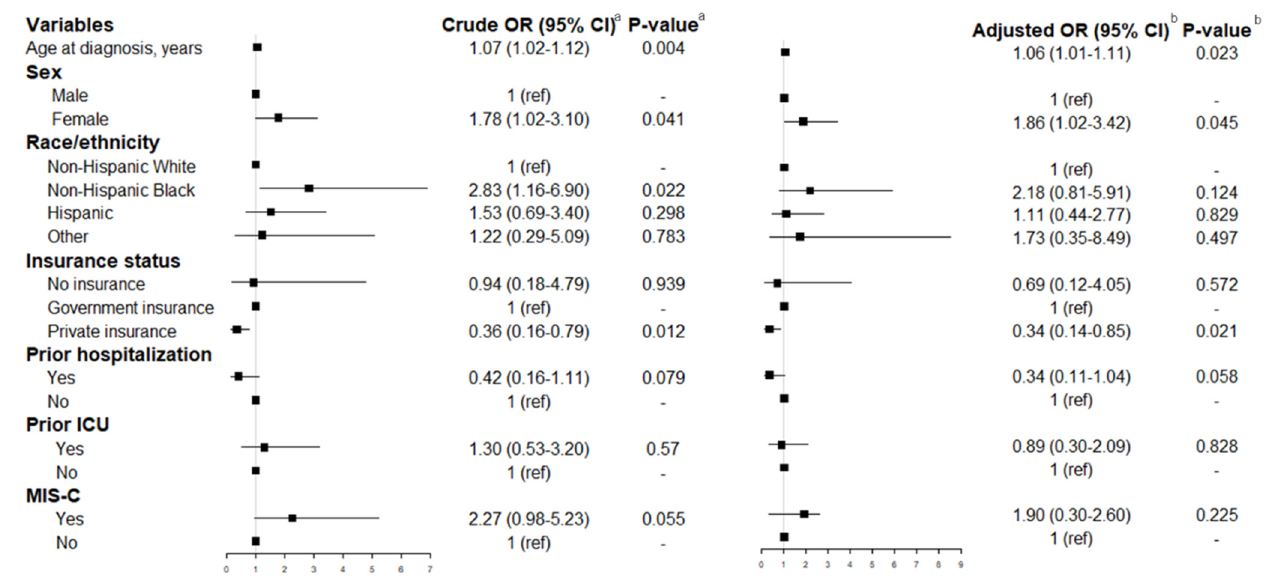
Figure 3. Odds of chronic long-term physical symptoms by demographic and clinical characteristics. a Crude logistic regression; b Multivariable logistic regression controlling for age at diagnosis, sex, race, insurance, prior hospitalization, ICU admission, and MIS-C status.